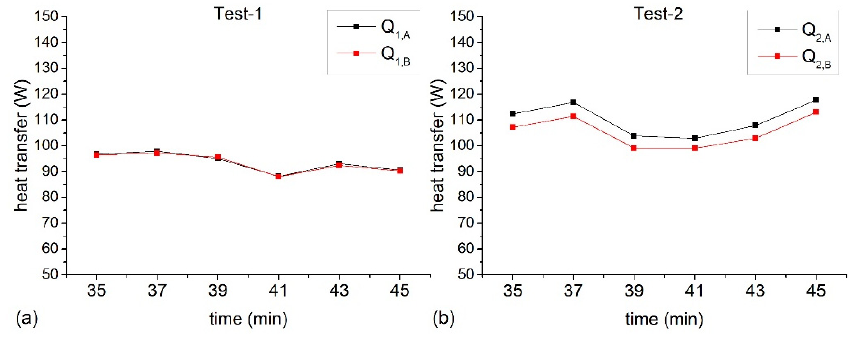
Figure 13. Heat transfer at each time point in the two tests: ( a ) Q1 in Test-1; ( b ) Q2 in Test-2.